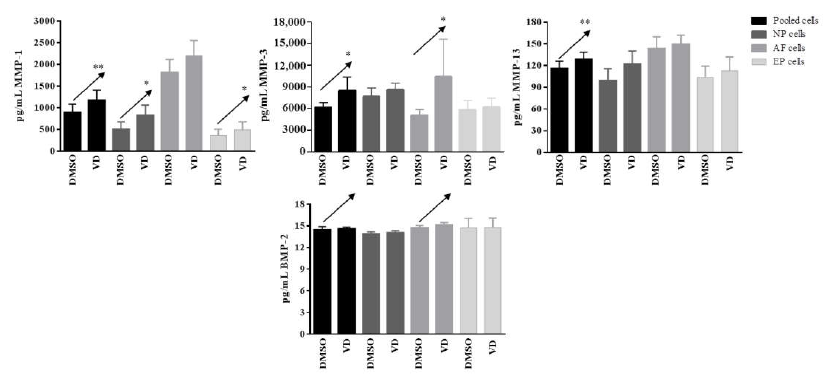
Figure 8. Levels of matrix-metalloproteases and BMP-2 secreted by pooled, NP, AF, and EP cells of